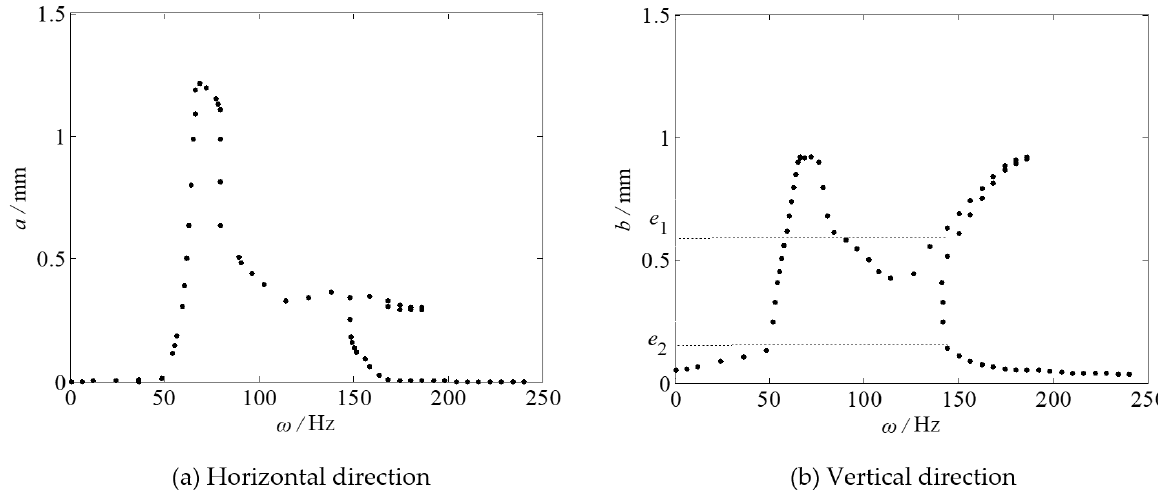
Figure 14. Amplitude–frequency curve of the coupled vibration system of hot rolling mill with piecewise nonlinear spring force constraint coefficient α = 1.5. ( a ) Amplitude–frequency curve of horizontal direction; ( b ) Amplitude–frequency curve of vertical direction.